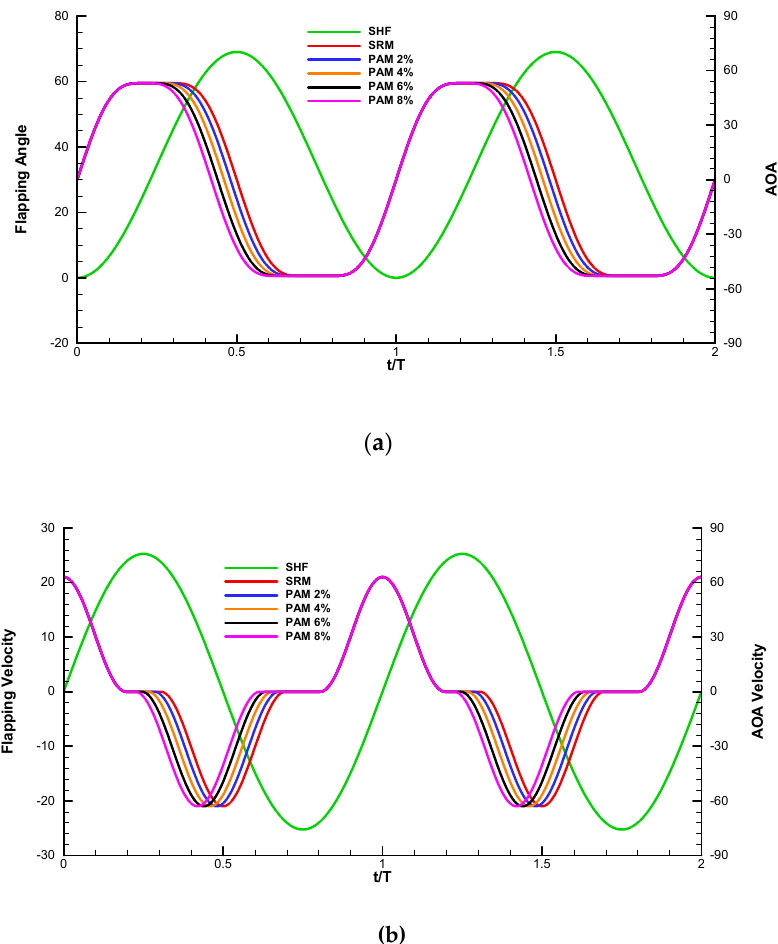
Figure 5. The time histories of flapping and attack angles ( a ) and flapping and AOA angular velocities ( b ) in two periods during hovering motion. (SHF: simple harmonic function; AOA: angle of attack; SRM: symmetrical rotation mode; PAM: partial advanced mode). ( a ) The time histories of flapping (green) and AOA angles; ( b ) The time histories of flapping (green) and AOA angular velocities.